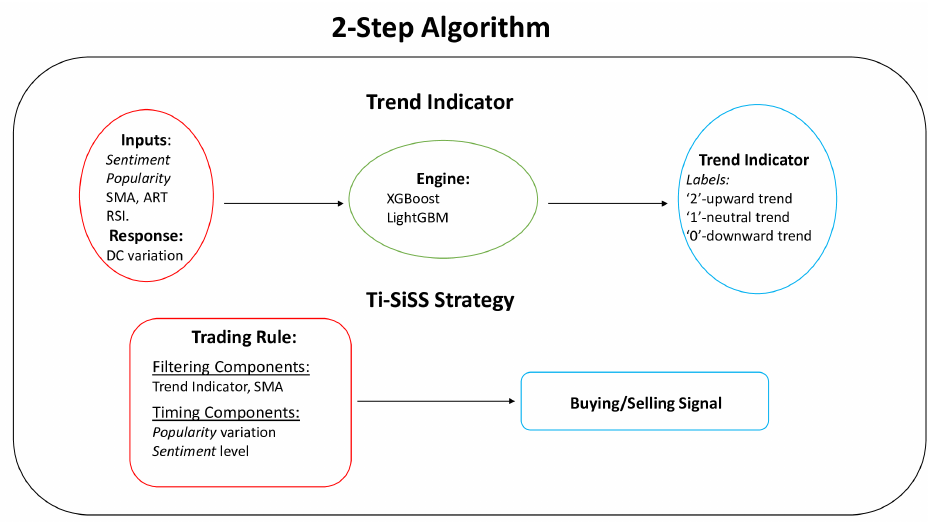
Figure 1. Description of the two-step trading